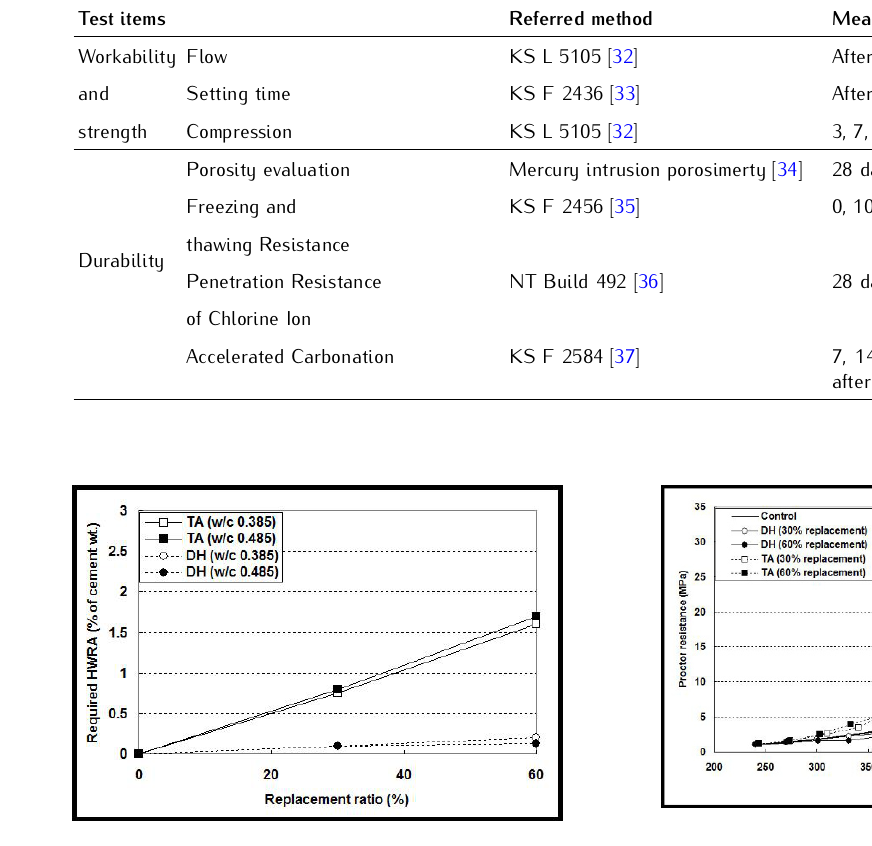
Figure 6. Proctor resistance with